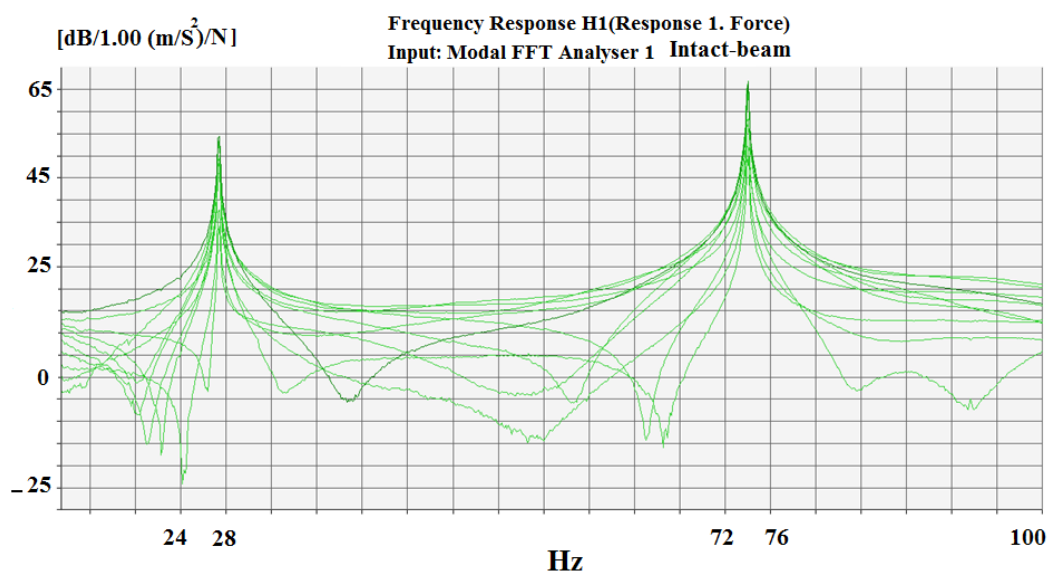
Figure 15. The frequency response functions obtained for the intact beam.